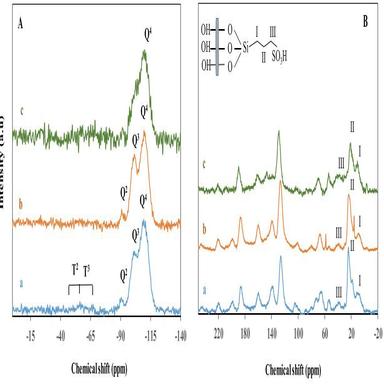
(A) 29Si MAS NMR and Fig. 4(B) 13C CP MAS NMR of Zn complex incorporated ordered mesoporous materials (a) MCM-41-S-Zn, (b) MCM-48-S-Zn and (c) SBA-15-S-Zn.